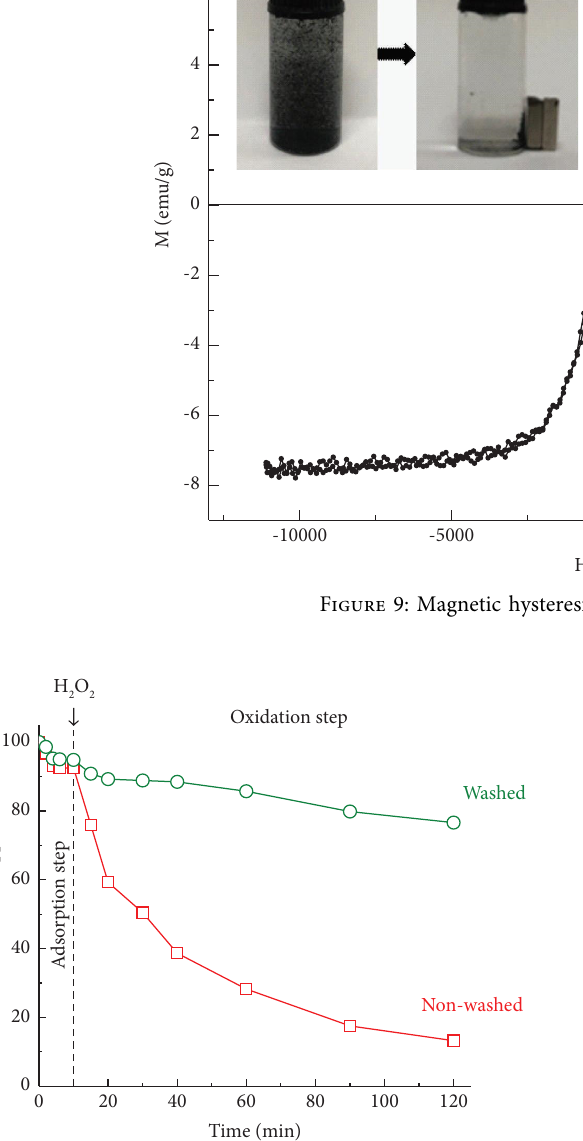
Figure 11: Efect of MPC catalysts prepared from diferent py- rolysis time on AY23 decolorization (0.80 g/L MPC-R0.2-yh, pH 3.0, 200ppm H 2 O 2